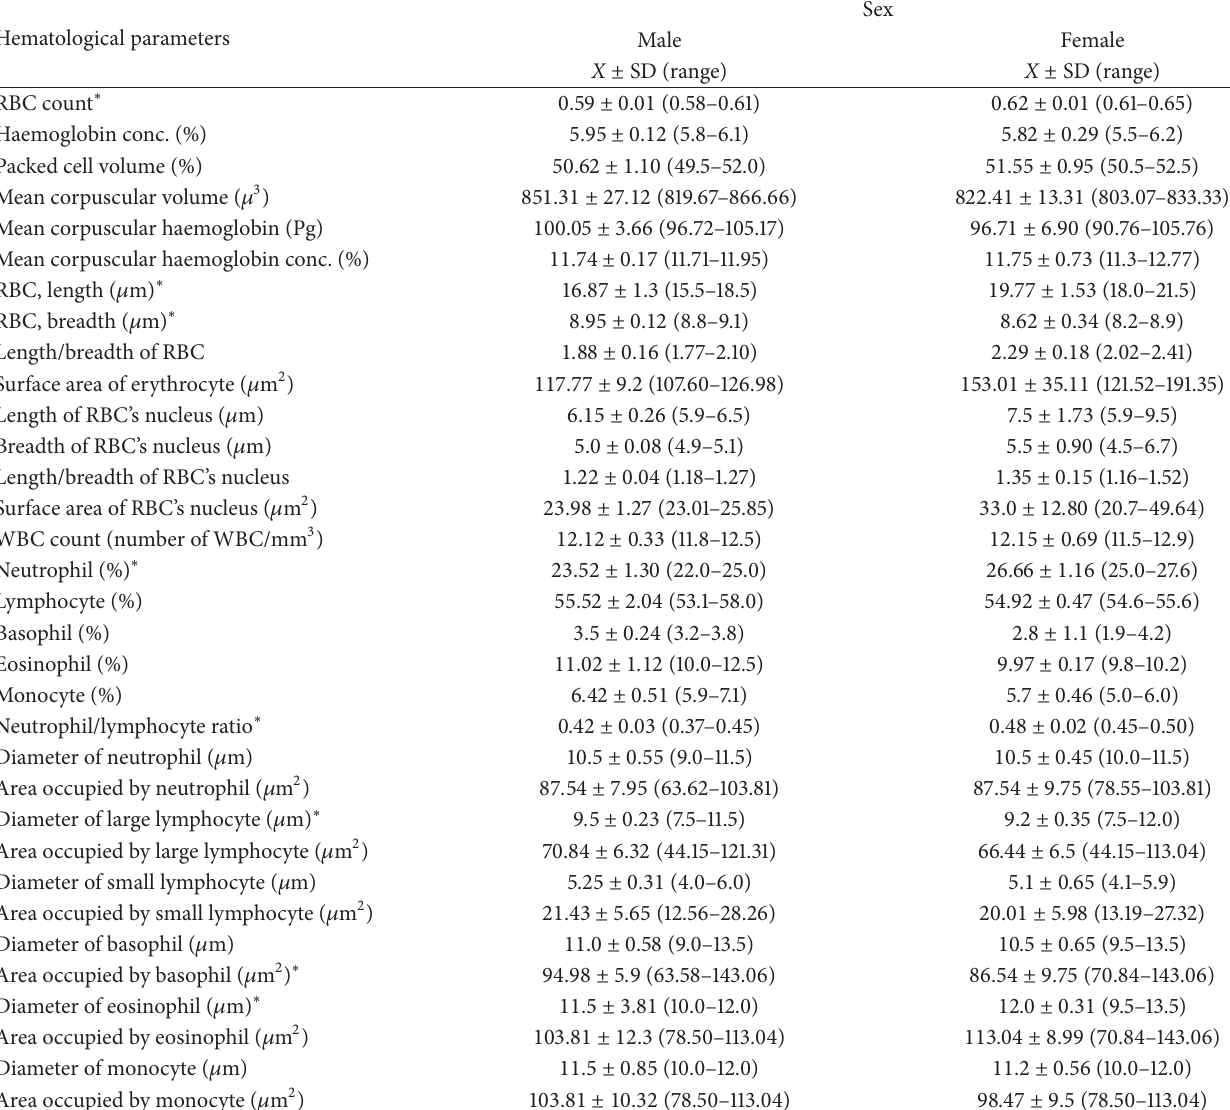
Table 1: Hematological parameters observed in adult males and females of Polypedates teraiensis. Hematological